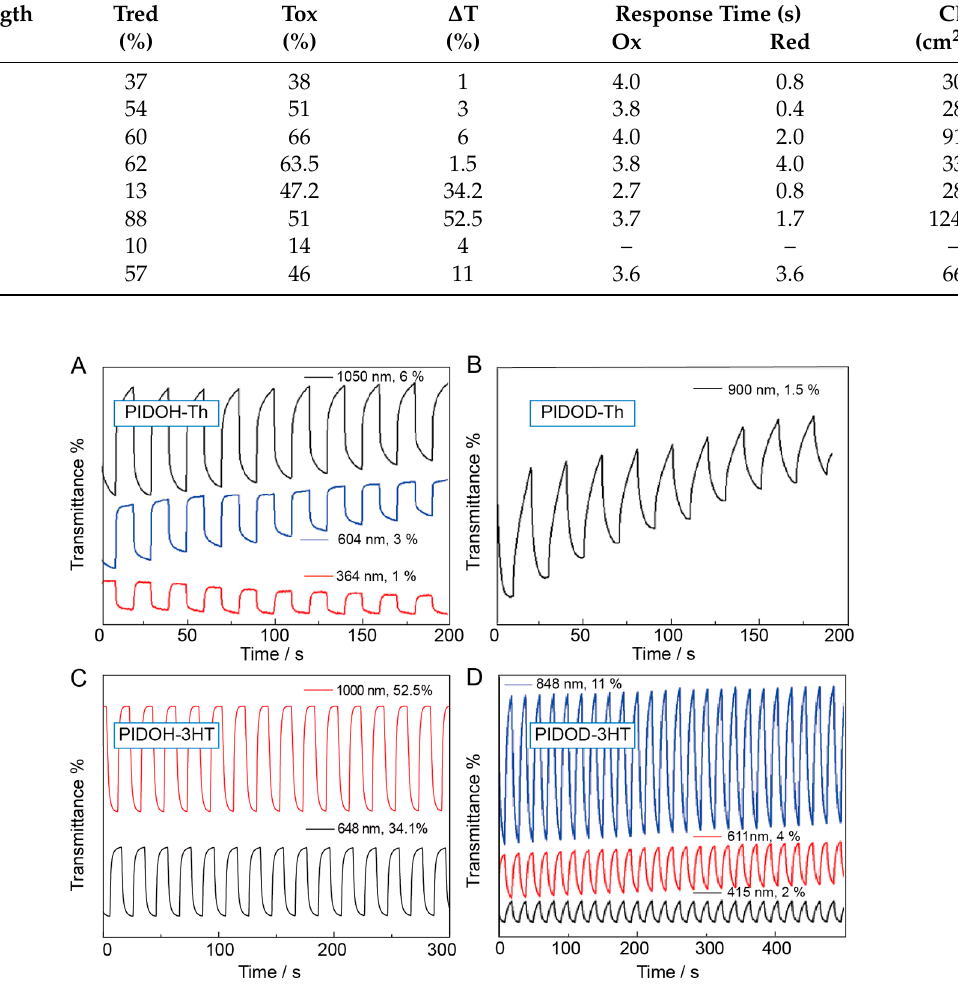
Figure 6. Time–transmittance profiles of ( A ) PIDOH–Th, ( B ) PIDOD–Th, ( C ) PIDOH–3HT, and ( D ) PIDOD–3HT at a switching time of 5 s under different wavelengths.